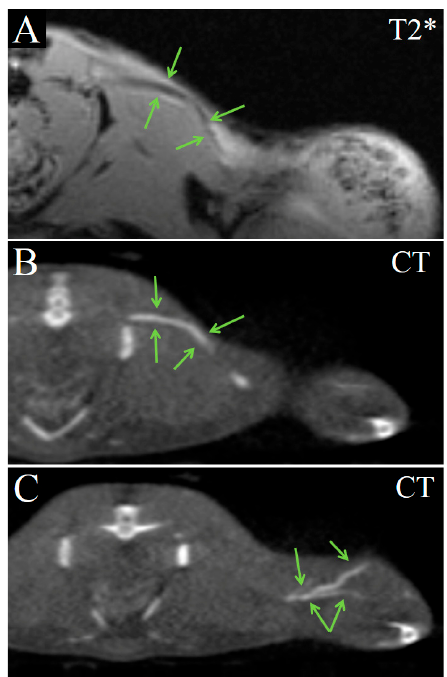
Figure 6. Transversal images demonstrate the enhancement of blood vessels. ( A ) T2* MRI 16 min post injection of Fe 3 O 4 @Au; ( B ) CT image 22 min post injection of Fe 3 O 4 @Au; ( C ) CT image of the tumor 22 min post injection of Fe 3 O 4 @Au. Arrows indicate blood vessels.